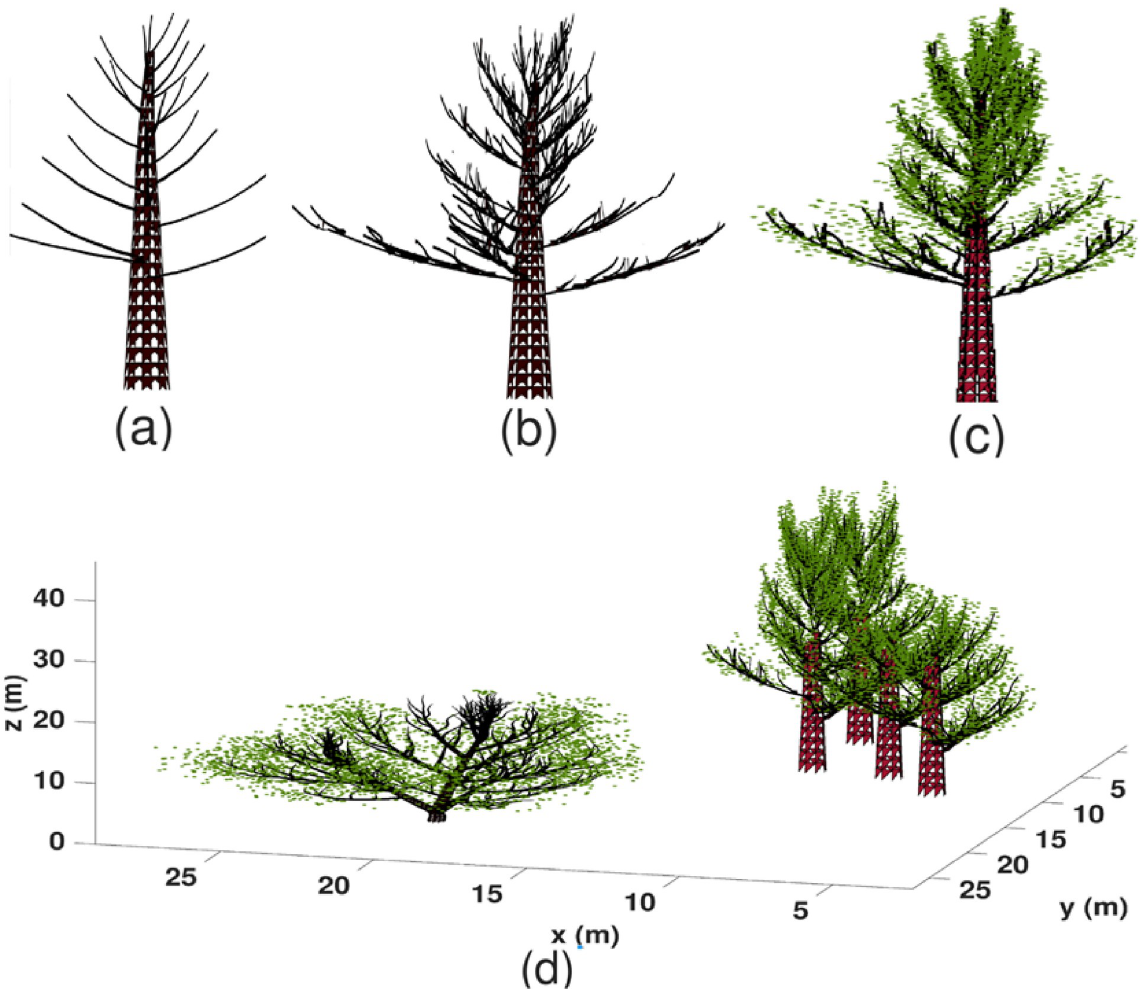
Fig 5. The simulation results of a single tree and a forest. (a) The first level branches generated by the L-system. (b) Sub-branches are added. (c) A view of the complete tree with leaves plotted as green dots. (d) The 3D visualization of a forest with two species of